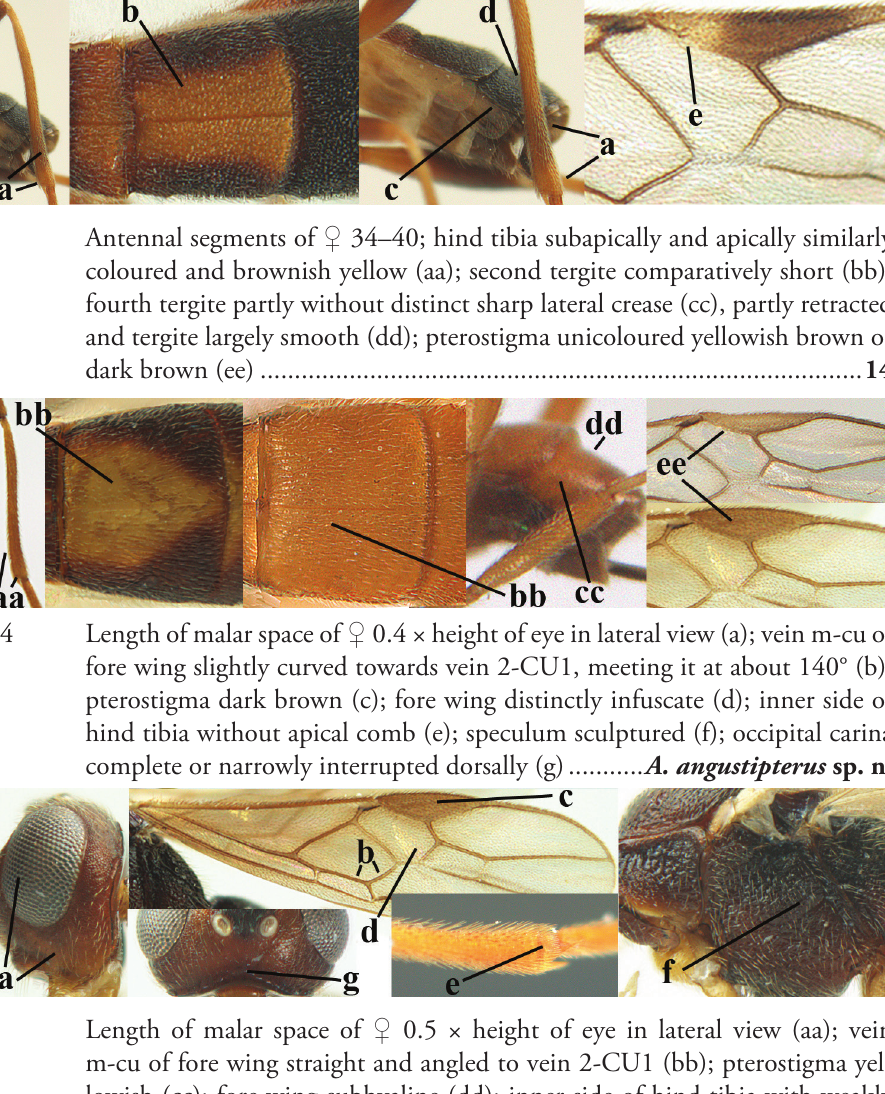
Antennal segments of ♀ 49–52; hind tibia infuscate subapically, contrasting with yellowish apex of tibia (a); second tergite comparatively long (b); fourth tergite with distinct sharp lateral crease (c) and basally rugulose or rugose (d); pterostigma bicoloured, with its basal third pale yellow (e); [vein m-cu of fore wing straight and angled to vein 2-CU1; antenna of ♀ sometimes with a narrow white or pale yellowish submedial band] .......... A. jakowlewi (Kokujev, 1898)